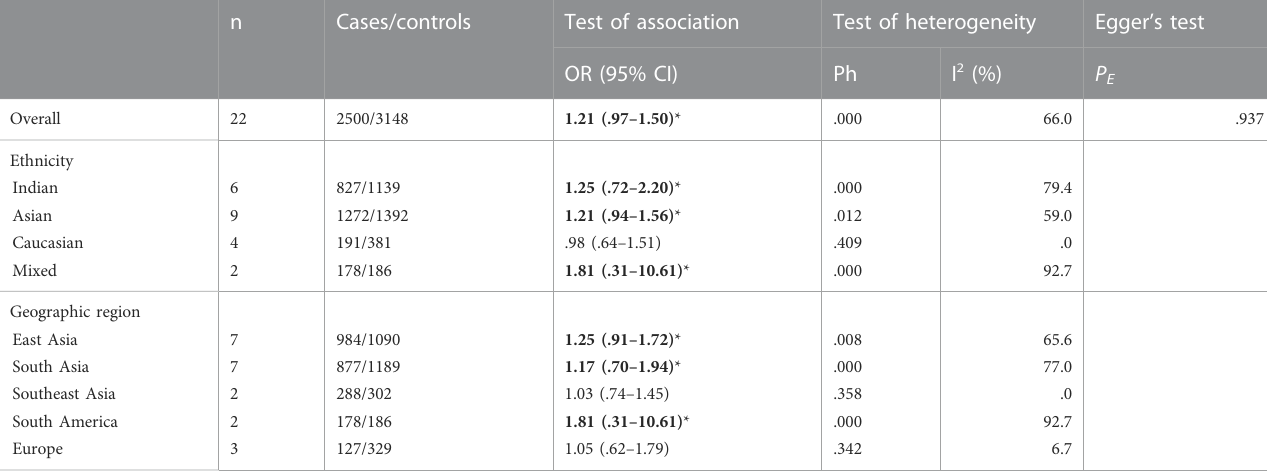
TABLE 5 Pooled estimates of the association of GSTT1 polymorphism with risk of cervical cancer.